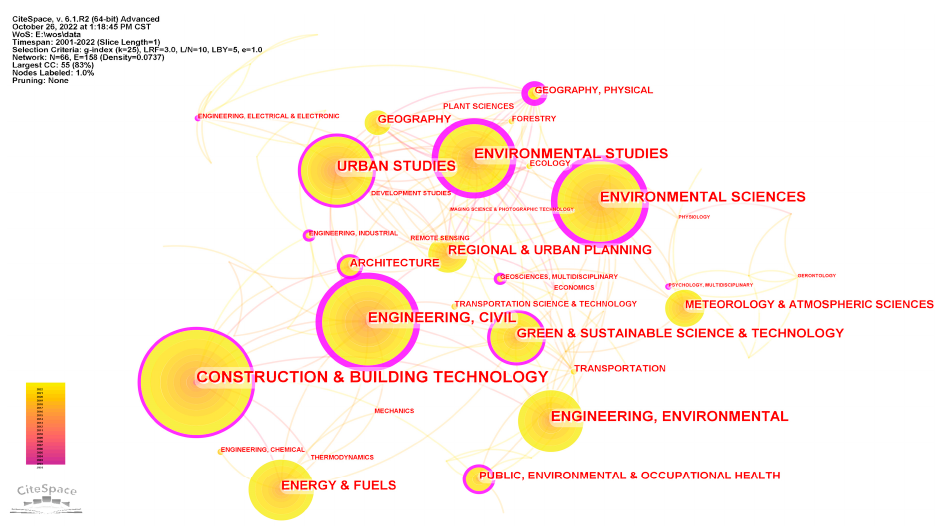
Figure 7. Knowledge map of major high-density city research categories from 2001 to 2022. Table 6. Major high-density city research categories from 2001 to 2022. No. Freq.